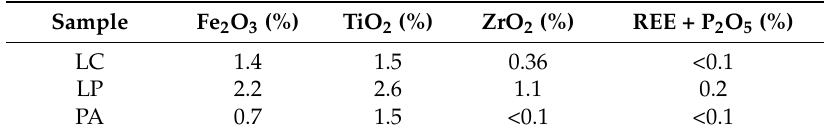
Table 2. Selected major elements of whole rock sample according to X-ray fluorescence spectrometry (XRF) results.